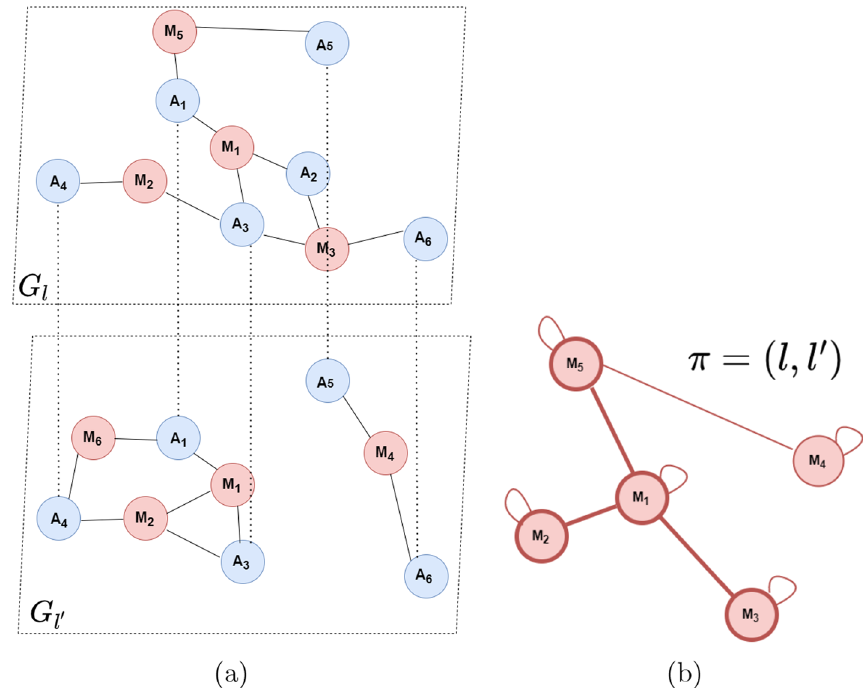
Fig. 7 All across-layer meta-path instances of type MAM ( a ), and the corresponding meta-path based graph for MAM type, with focus on entity M 1 and its neighbors ( b